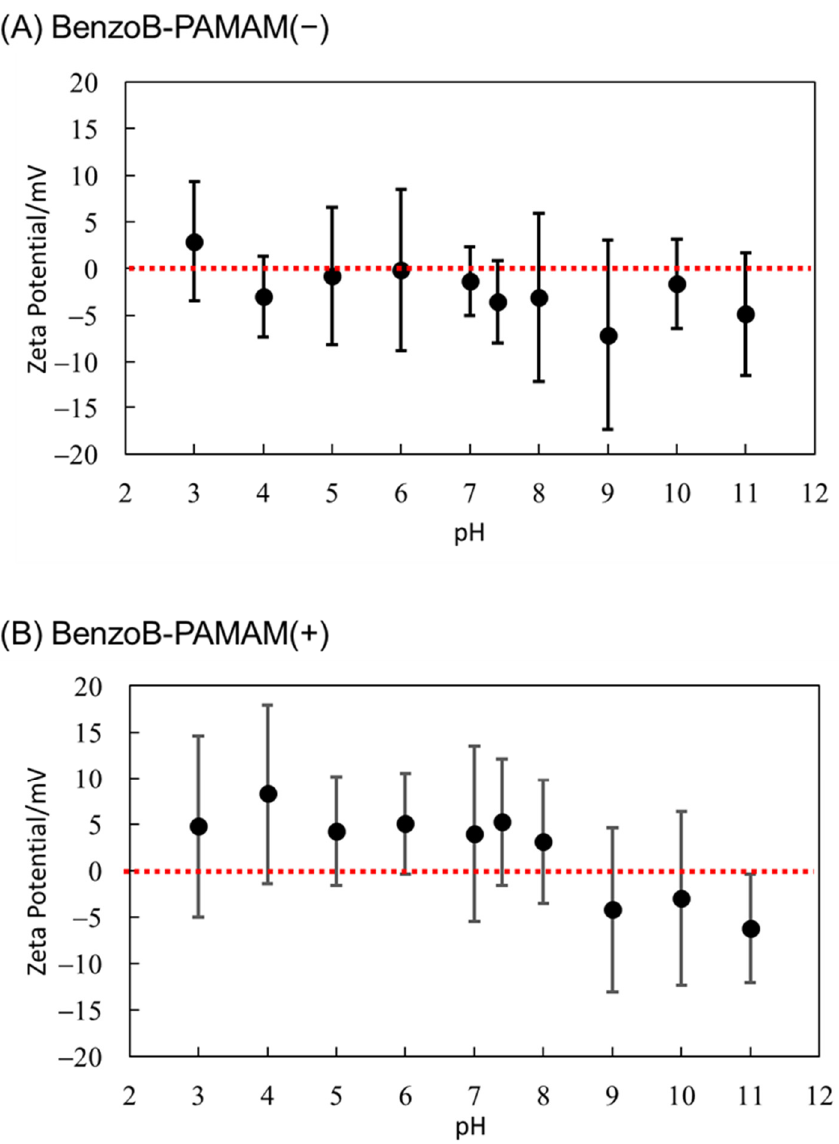
Figure 3. Zeta potential measurement of BenzoB-PAMAMs in PBS ( n = 5). [probe] = 6.6 × 10 − 6 M. Bars express standard deviations (SDs) from five independent experiments. ( A ) BenzoB-PAMAM( − ). ( B )